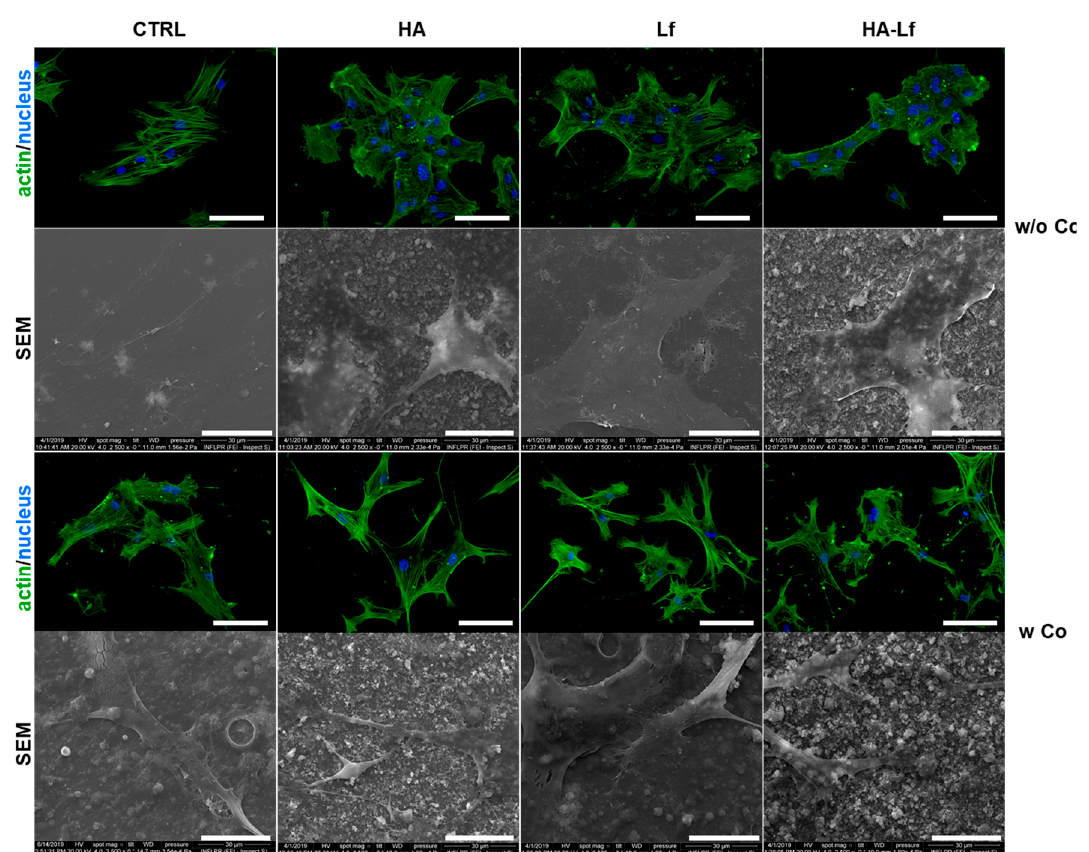
Figure 8. Representative fields of view of human mesenchymal stem cell adhesion and actin cytoskeleton organisation for each surface obtained by fluorescence microscopy. Cell F-actin (green) and nucleus (blue) were examined using a 20× lens. Scale bar is 100 μ m. SEM micrographs were taken with 2500× objectives of hMSCs on substrates. Scale bar represents 30 μ m.